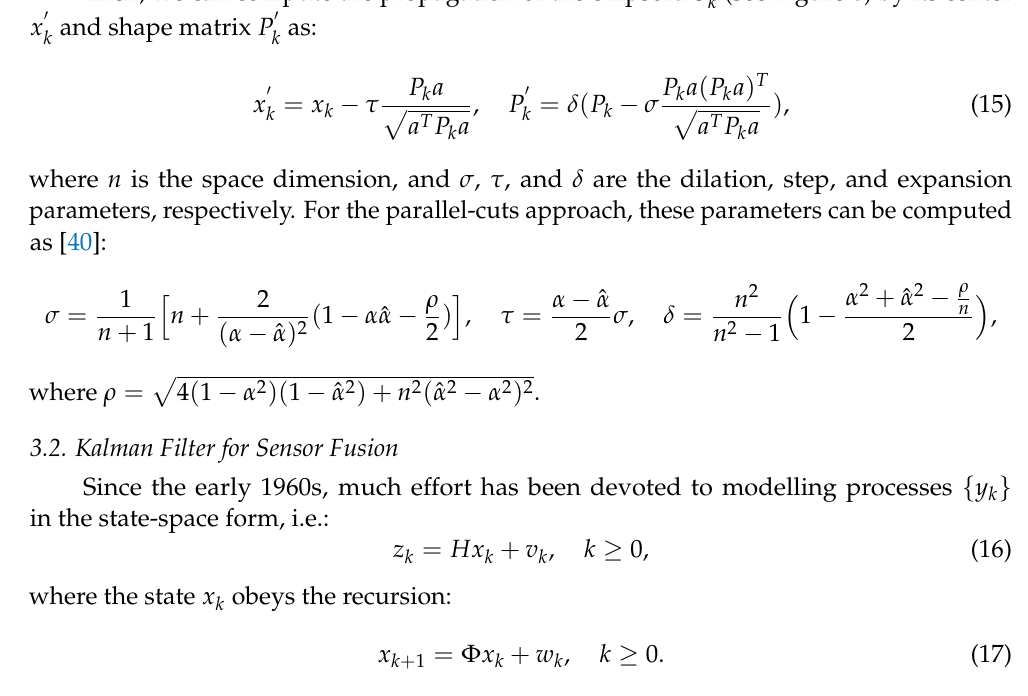
Figure 6. Propagation of the uncertainty ellipsoid E k at time k + 1, i.e., E (cid:48) method. E (cid:48) represents the ellipsoid at minimum volume containing the feasible point set (yellow k